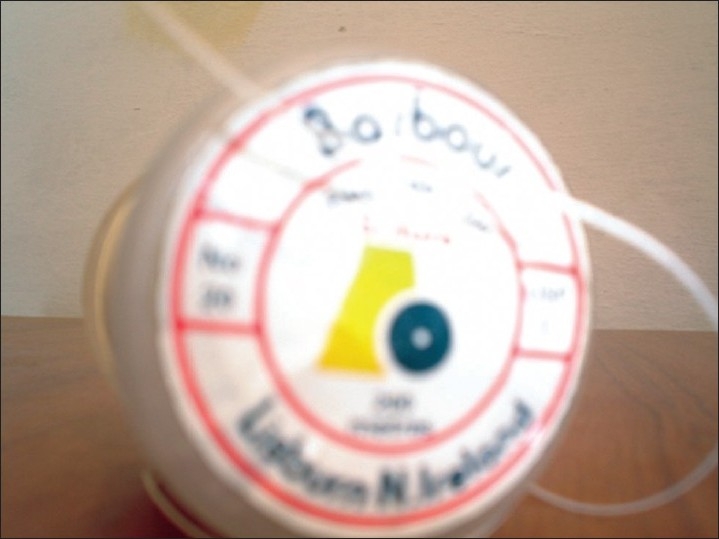
Barbour's linen